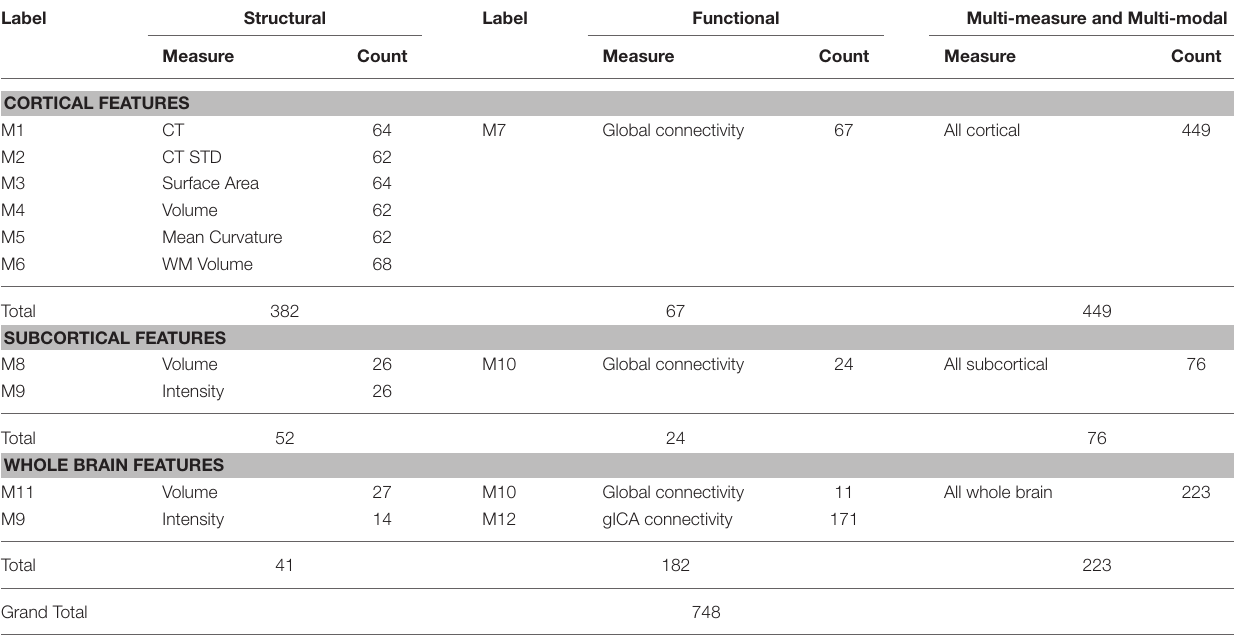
TABLE 2 | Summary of the features used in this